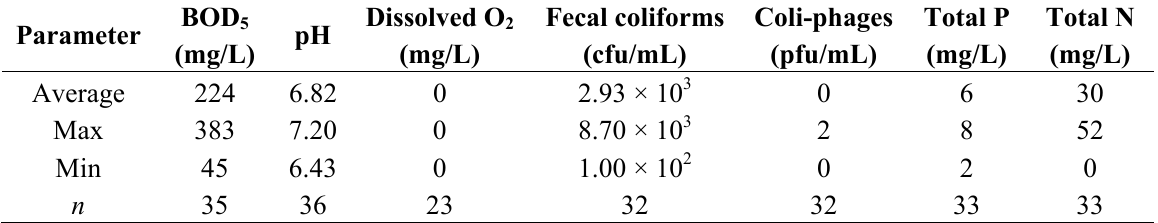
Table 1. Chemical and microbial properties of septic tank effluent .